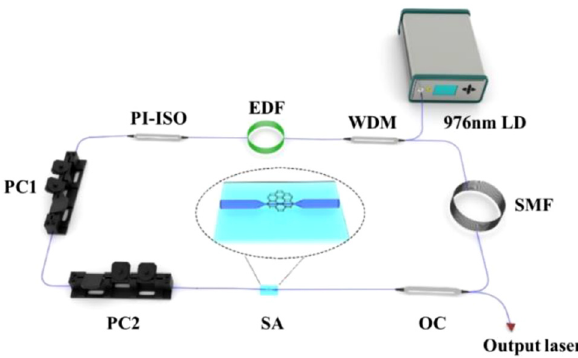
S -PVA film. (Inset) 2 3